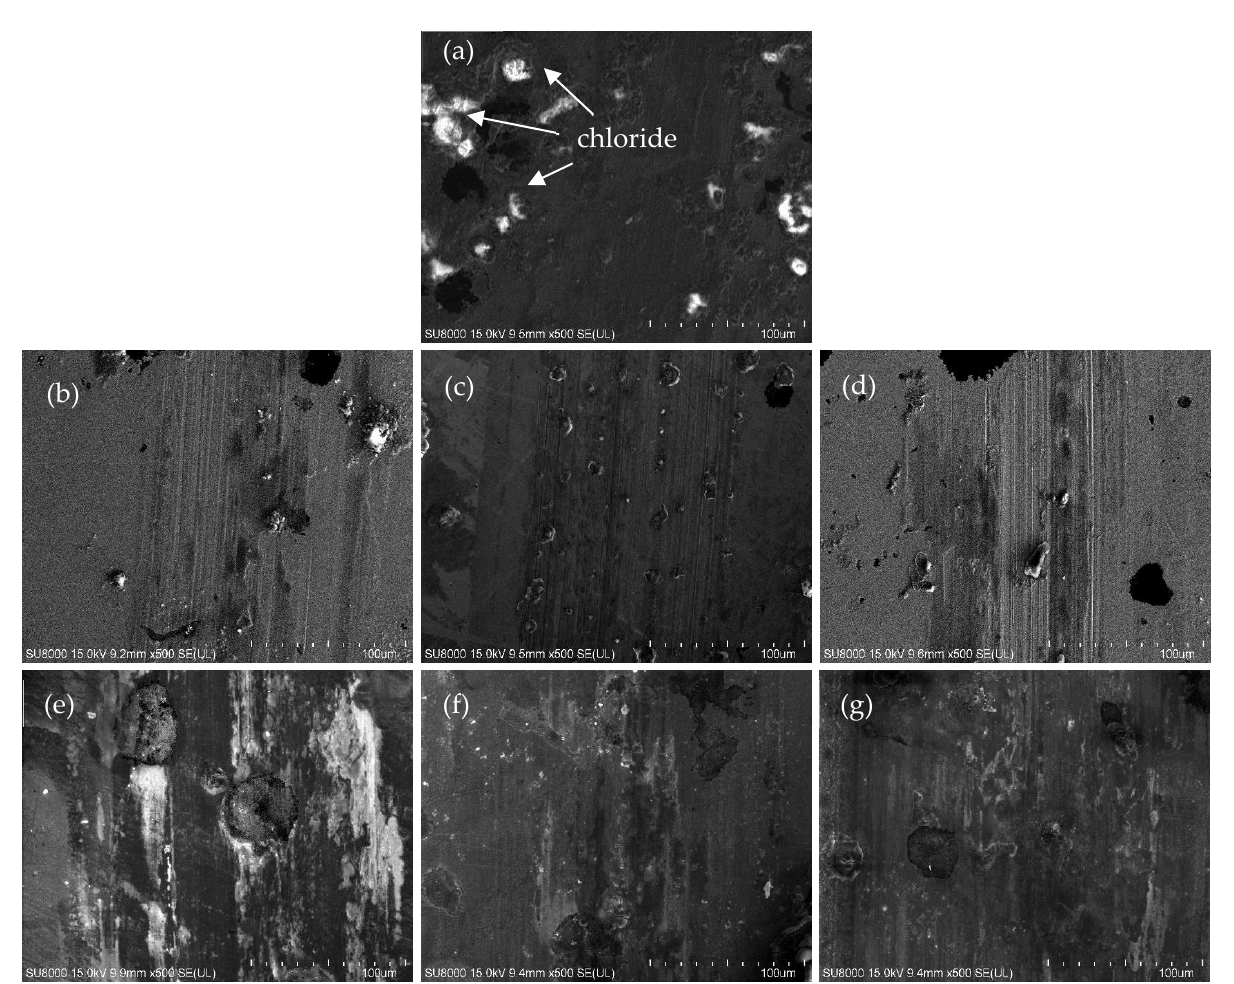
Figure 12. Surface worn tracks of the specimens after wet wear testing: ( a ) as-cast, ( b ) 300–1 h, ( c )